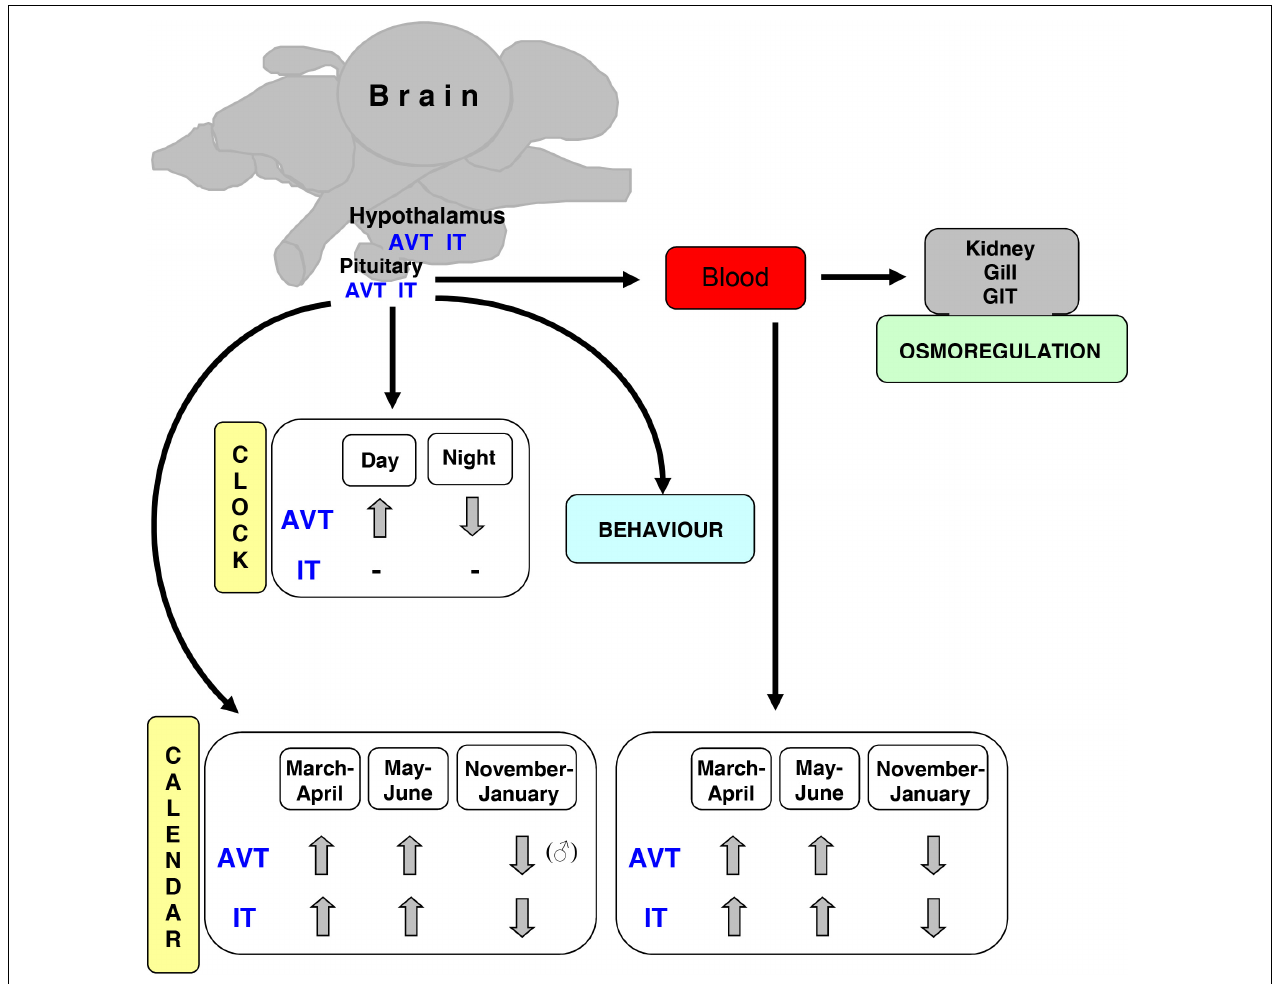
FIGURE 1 | Scheme of AVT and IT activities in fish (AVT-arginine vasotocin, IT-isotocin, GIT-gastrointestinal